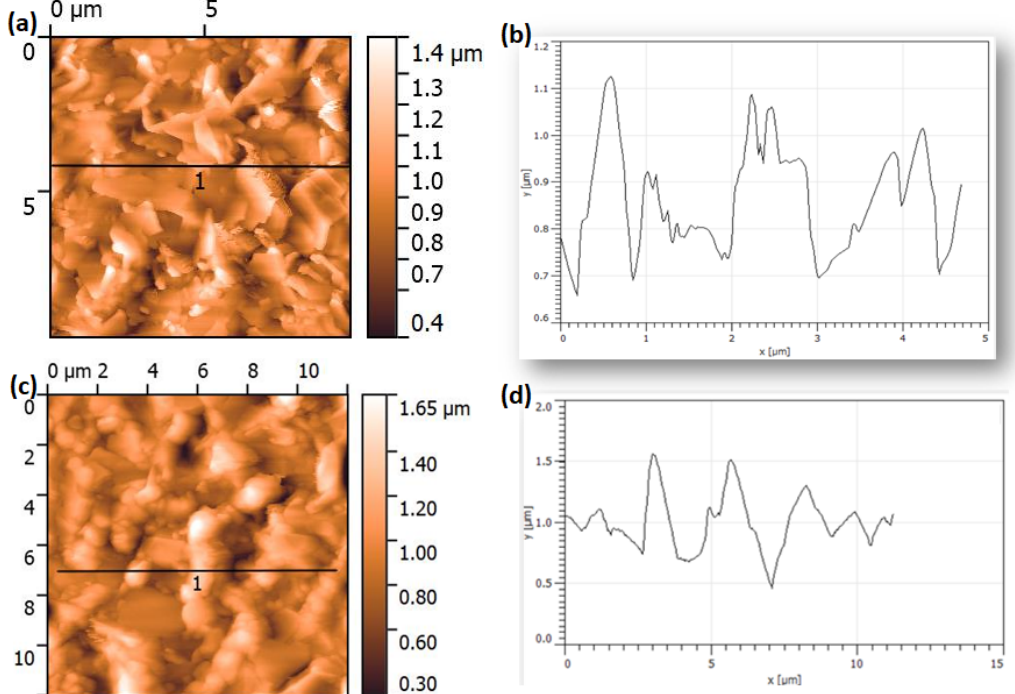
Figure 6. AFM image of GNSs ( a ) and Co − Por − GNSs ( c ). High profile of the black line in the image of GNSs ( b ) and Co − Por − GNSs ( d ). GNSs ( b ) and Co-Por-GNSs ( d